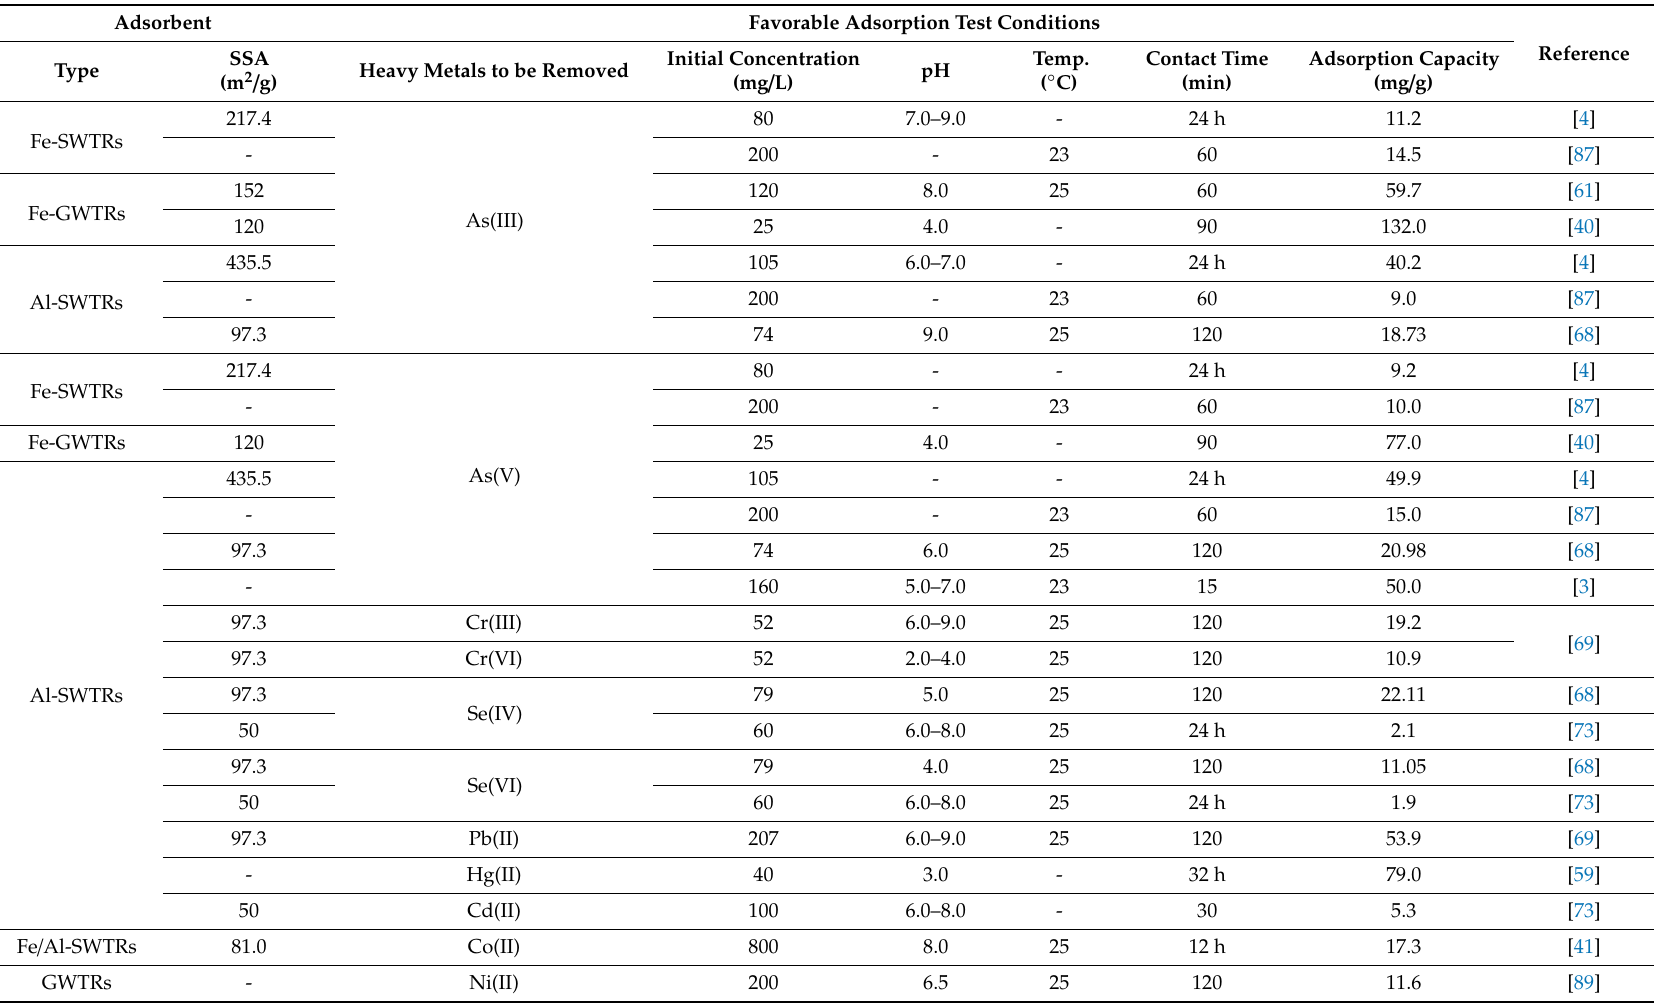
Table 4. Main characteristics and uptake capacities of WTRs for heavy metals and metalloids removal (SSA—specific surface